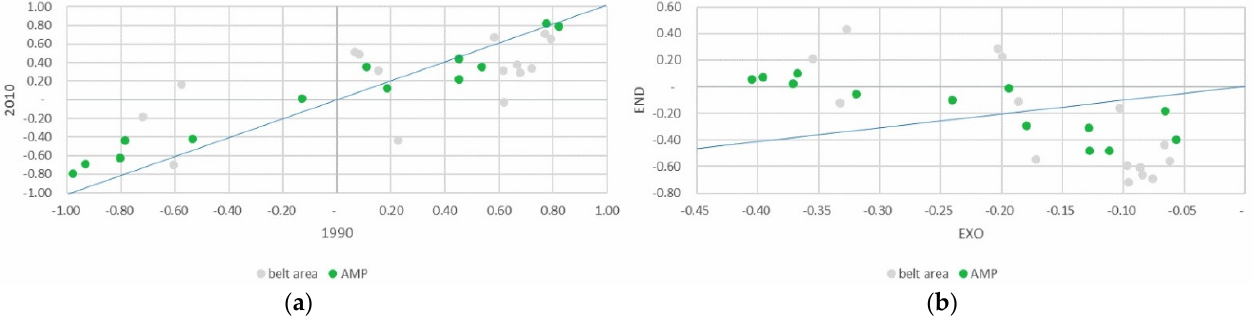
Figure 21. ( a , b ) PSI and DPSI for orchards. Source: Drawn up by the authors using data provided by the ISTAT.